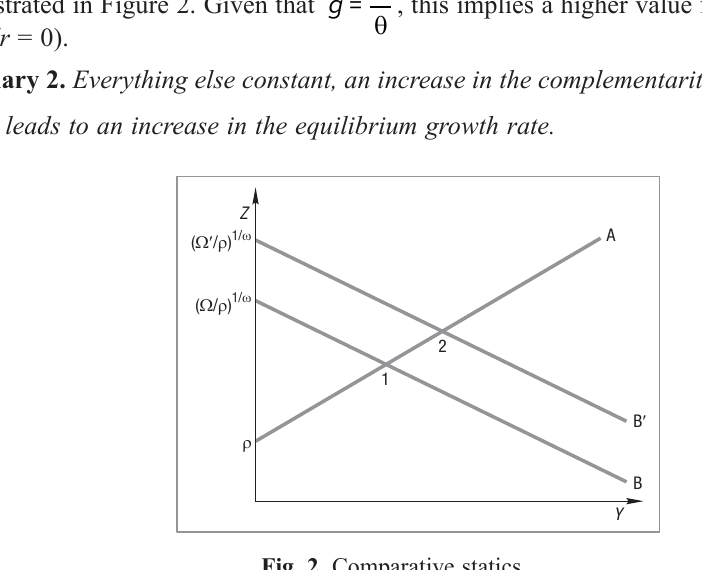
Fig. 2. Comparative